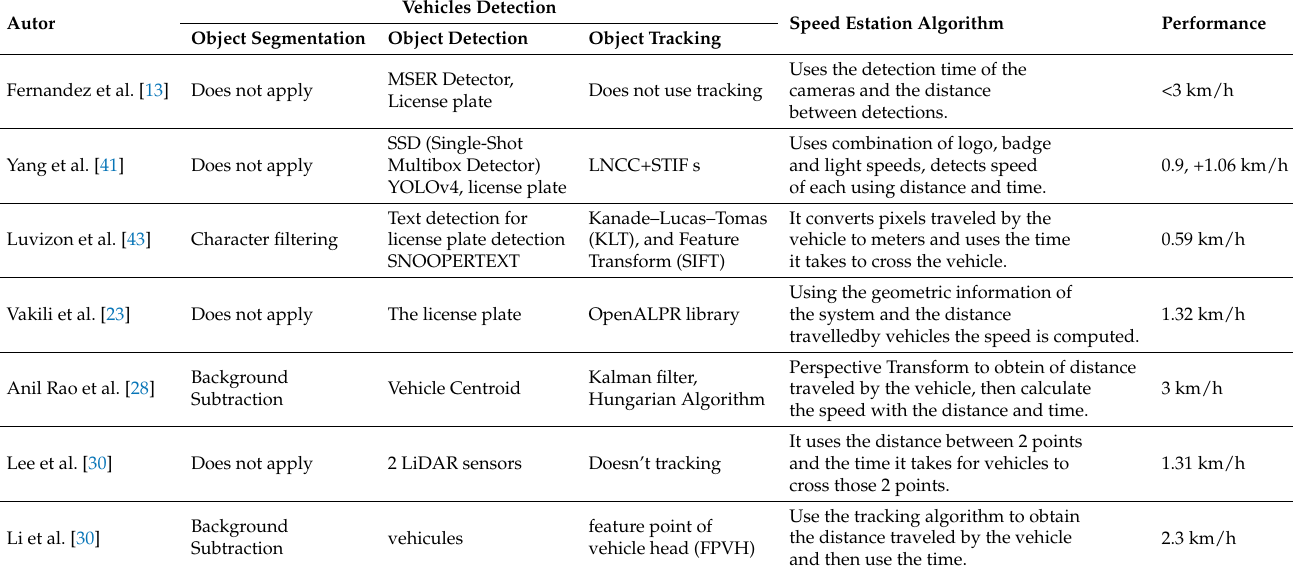
Table 7. Comparison of speed estimation process between state-of-the-art works and our